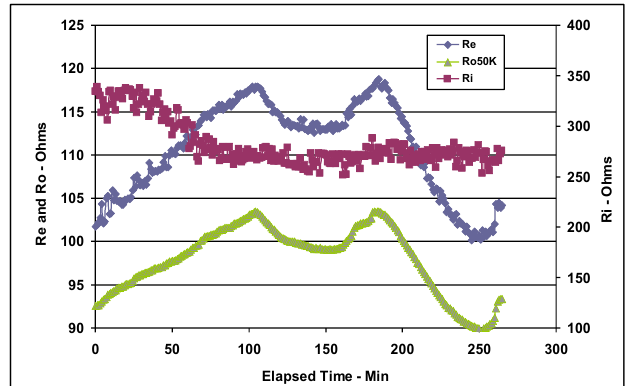
Fig. 9: Basal resistances.